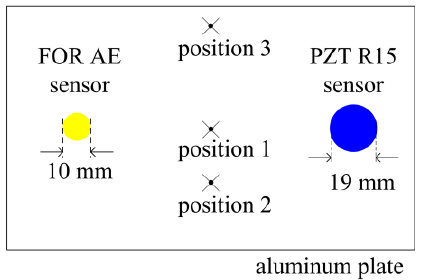
Figure 8. AE sensor experiment.